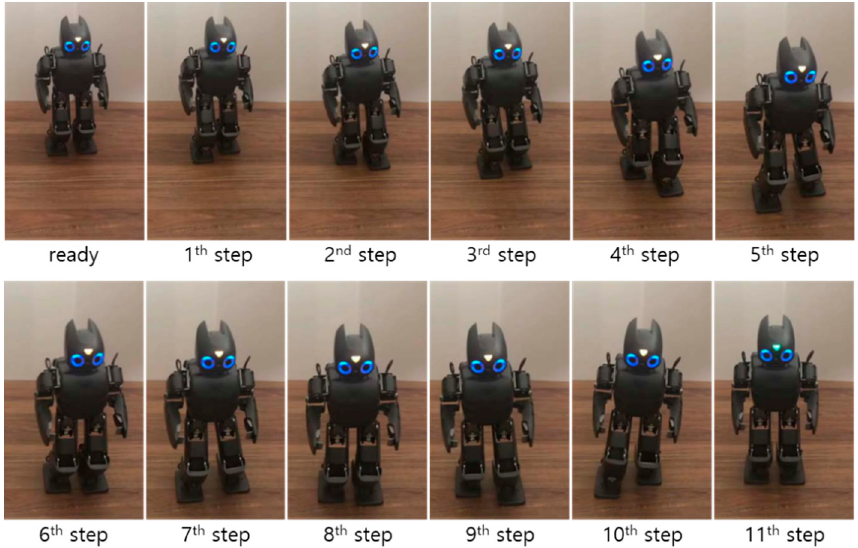
Figure 16. Snapshots of the experiment result with the proposed CP-based walking stability controller (left to right, top to bottom).